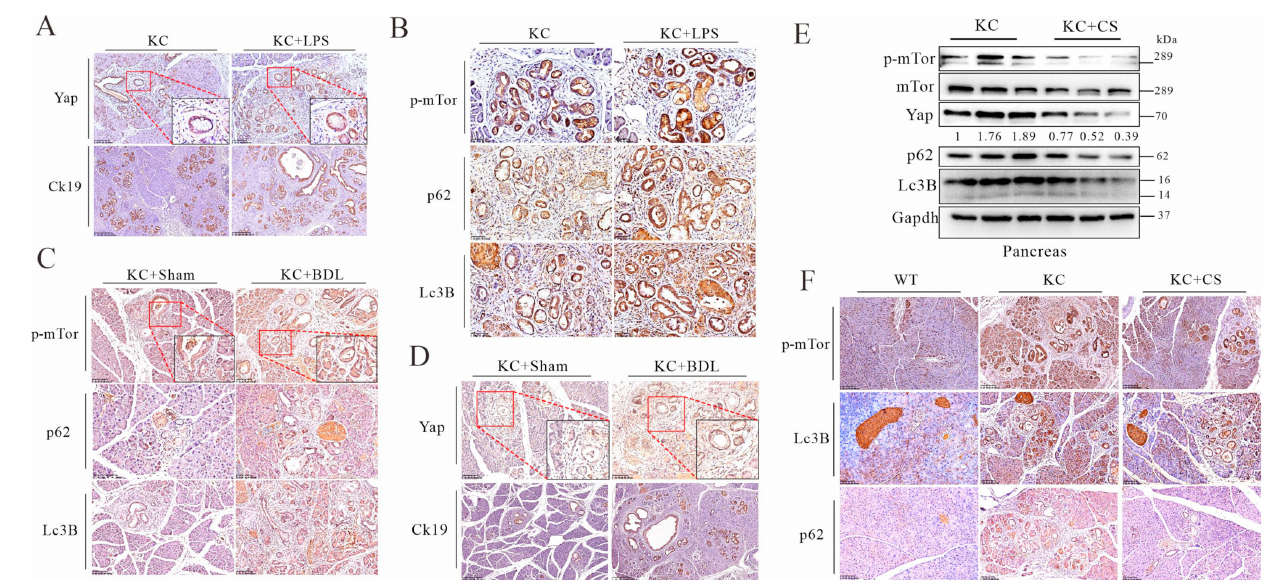
Figure 3. Oral administration of cationic resin leads to mobilization of autophagic flux for Yap degradation in pancreatic cancer tissues. Experimental conditions were described in Figure 1. ( A ) IHC staining of pancreatic tissue for Yap (scale bars = 100 µ m) and Ck19 (scale bars = 250 µ m) in KC mice treated with vehicle or LPS. ( B ) IHC staining of pancreatic tissue for p-mTor (scale bars = 50 µ m), p62 (scale bars = 50 µ m) and Lc3B (scale bars = 50 µ m) in KC mice treated with vehicle or LPS. ( C ) IHC staining for p-mTor (scale bars = 100 µ m), p62 (scale bars = 100 µ m), and Lc3B (scale bars = 100 µ m) in KC mice that received sham or BDL. ( D ) IHC staining for Yap (scale bars = 100 µ m) and Ck19 (scale bars = 250 µ m) in KC mice that received sham or BDL. ( E ) Western blot analysis of KC mouse pancreases treated with vehicle or cholestyramine (CS). ( F ) IHC staining for p-mTor, Lc3B, and p62 in WT mice and KC mice treated with vehicle or CS. Scale bars = 100 µ m. The original Western Blot figures can be found in the Supplementary File